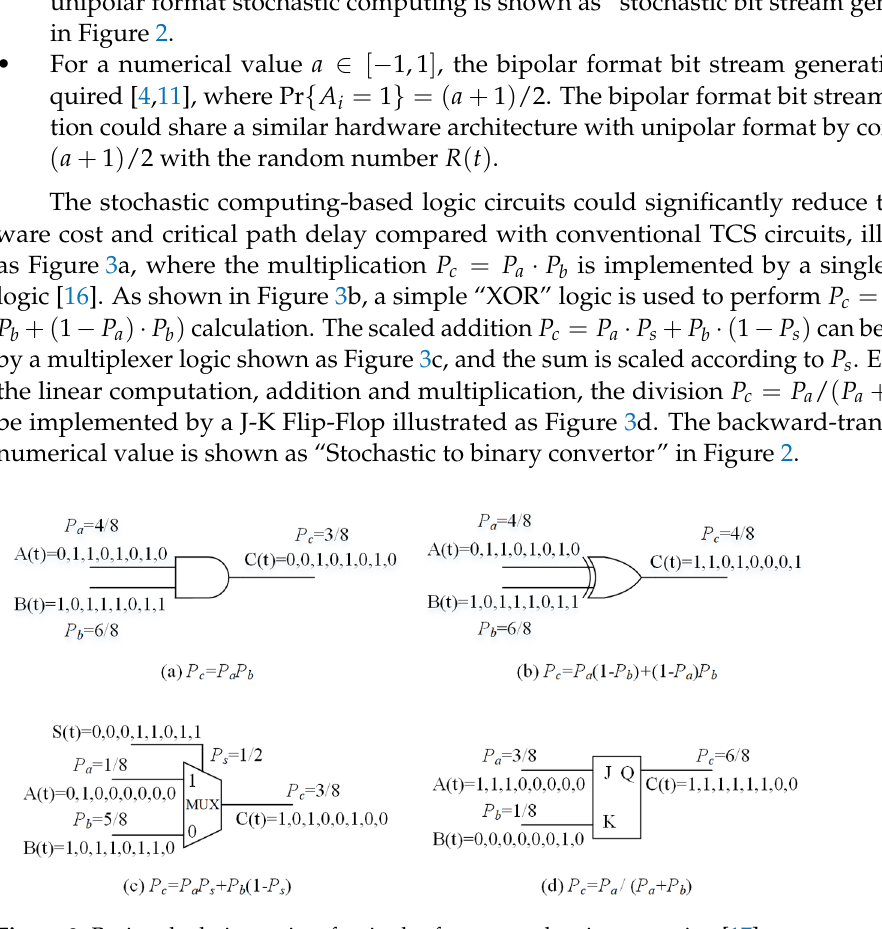
Figure 3. Basic calculation units of unipolar format stochastic computing